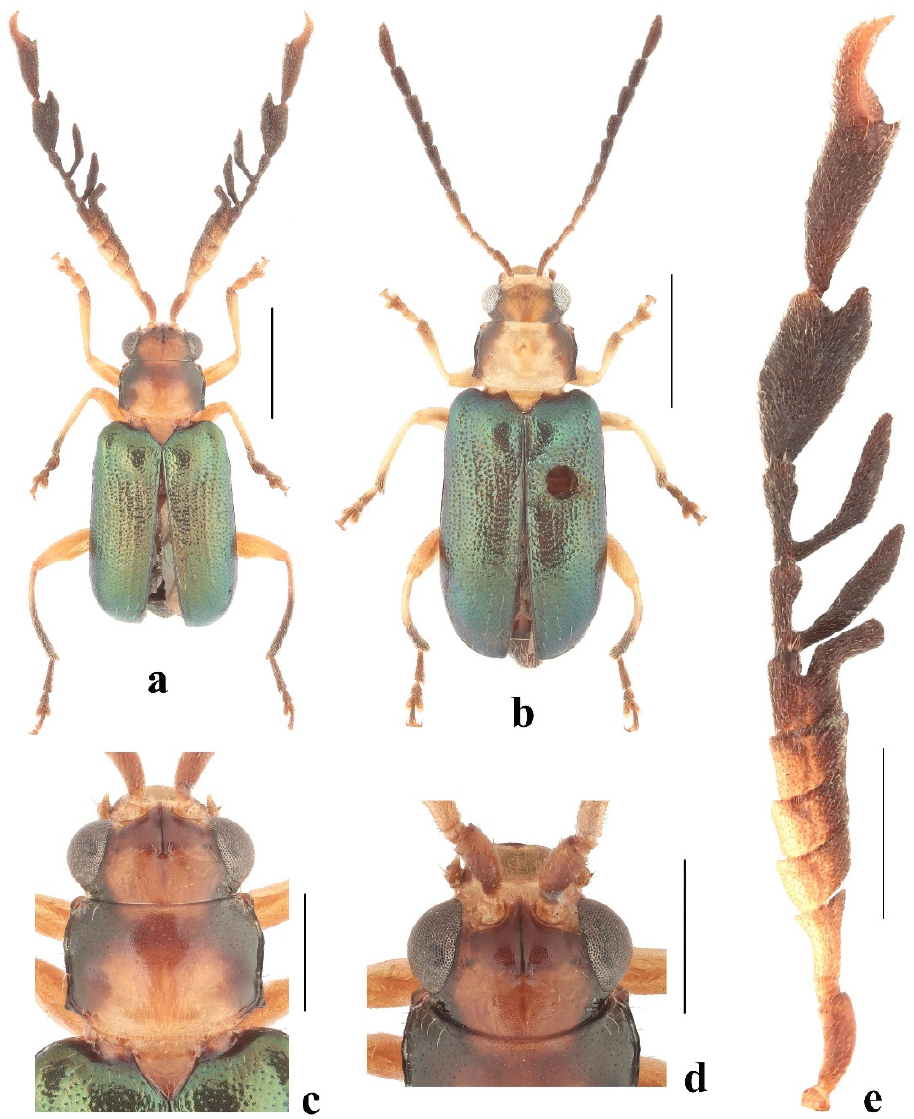
Figure 2. Taumacera cervicornis (Baly, 1861): ( a ) male; ( b ) female; ( c ) head and pronotum, dorsal view; ( d ) head, frontal view; ( e ) left antenna. (Scale bars: ( a , b ) = 2 mm, ( c – e ) = 1 mm).